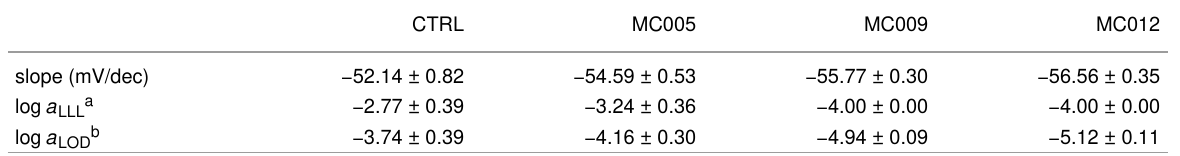
Table 2: The response characteristics of each membrane determined from the potentiometric calibrations in sodium acetate. The upper linear limit was 10 − 1.11 M in all cases and activities greater than that were not measured. The uncertainties express standard deviations. CTRL